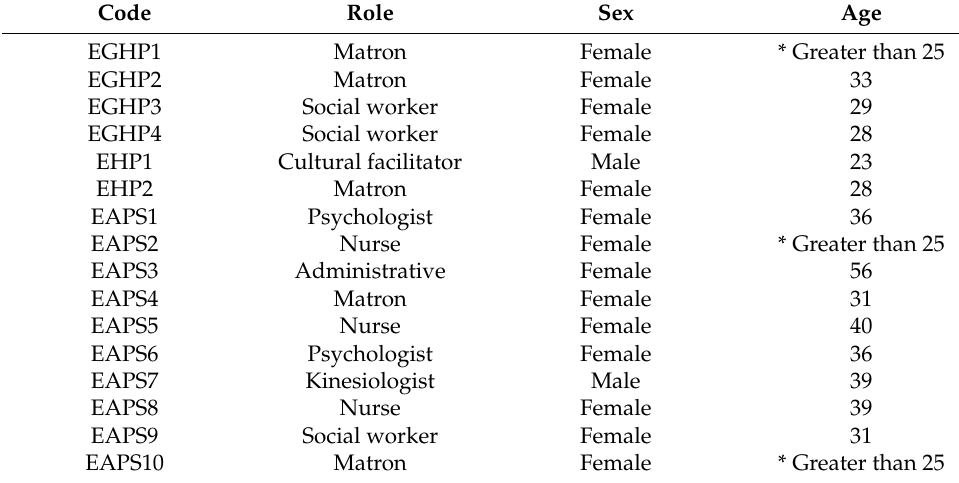
Table 1. Participants’